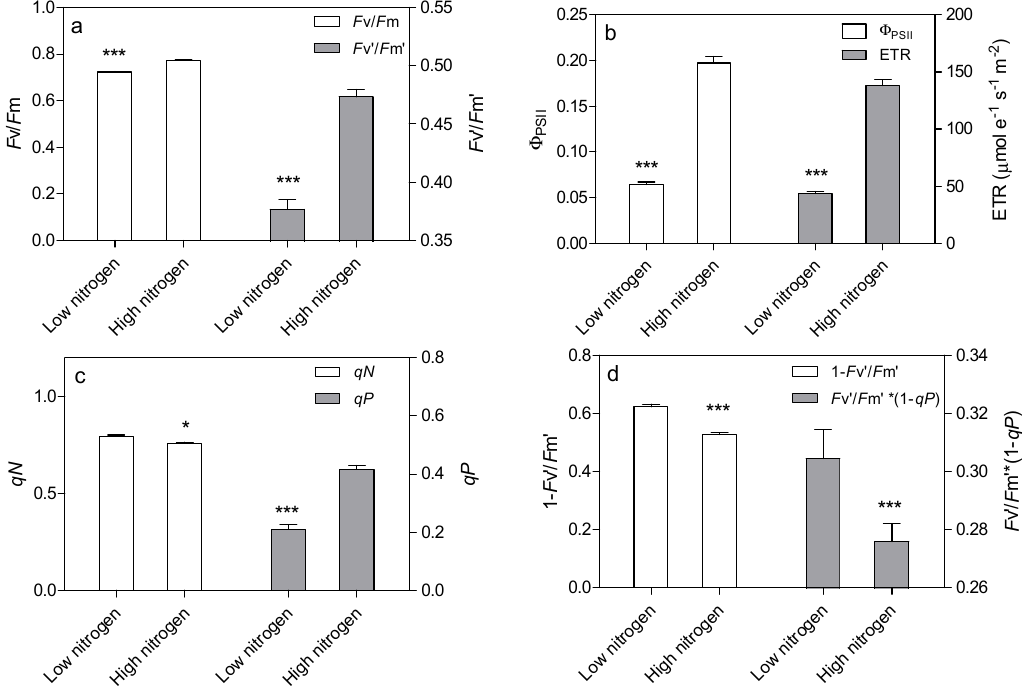
Figure 6. Effect of nitrogen supply on chlorophyll fluorescence parameters in the sixth leaf of maize. Effect of nitrogen supply on F v/ F m and F v’/ F m’ ( a ), on Φ PSII and ETR ( b ), on qN and qP ( c ), on 1 − F v’/ F m’ and F v’/ F m’ · * (1 − qP ) ( d ). High nitrogen: 4 mM Ca(NO 3 ) 2 ; Low nitrogen: 40 µM Ca(NO 3 ) 2 . Bars denote the SE of the mean. ns: not significant ( p > 0.05); *, ** and ***: significant at p < 0.05, 0.01 and 0.001, respectively.